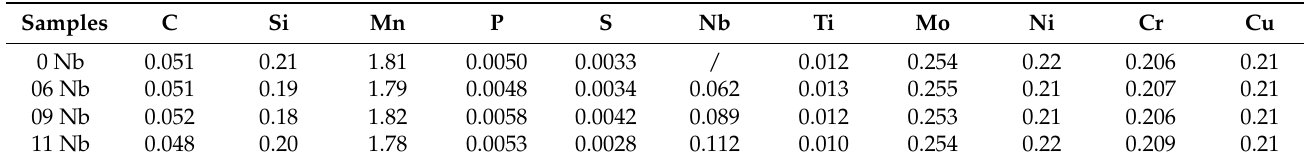
Table 1. Chemical compositions of experimental steels